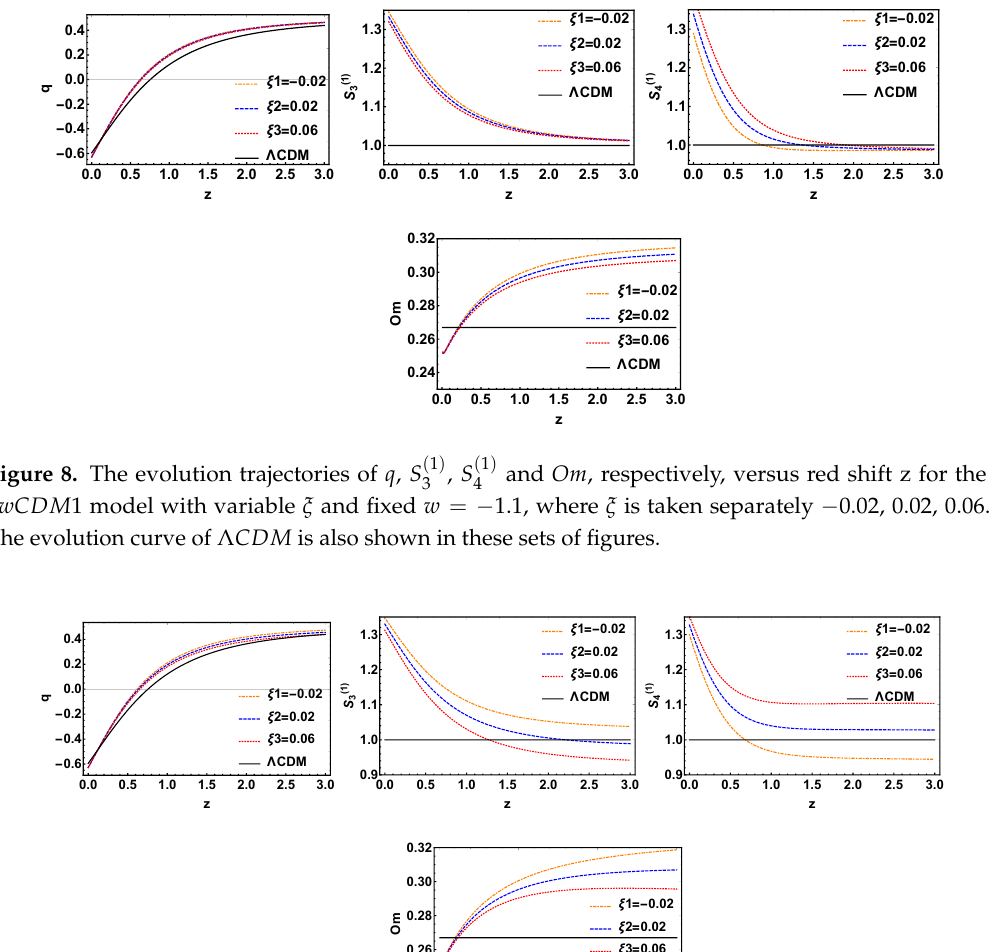
Figure 9. The evolution trajectories of q , S IwCDM 2 model with variable ξ and fixed w = − 1.1, where ξ is taken separately − 0.02, 0.02, 0.06. The evolution curve of Λ CDM is also shown in these sets of